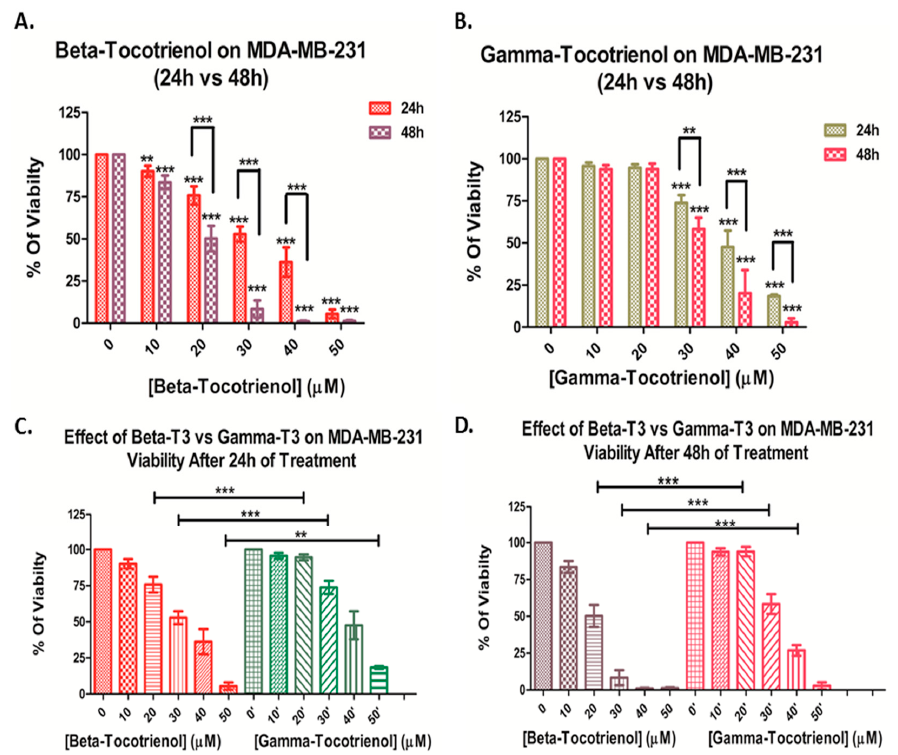
Figure 1. Proliferation of MDA-MB-231 cells after 24 and 48 h of treatment with various concentrations of beta- ( A ) and gamma-( B ) tocotrienols (0–50 µ M). Significance between both treatments was tested after 24 h ( C ) and 48 h ( D ). ** and *** indicate p < 0.001 and p < 0.0001 respectively. 217